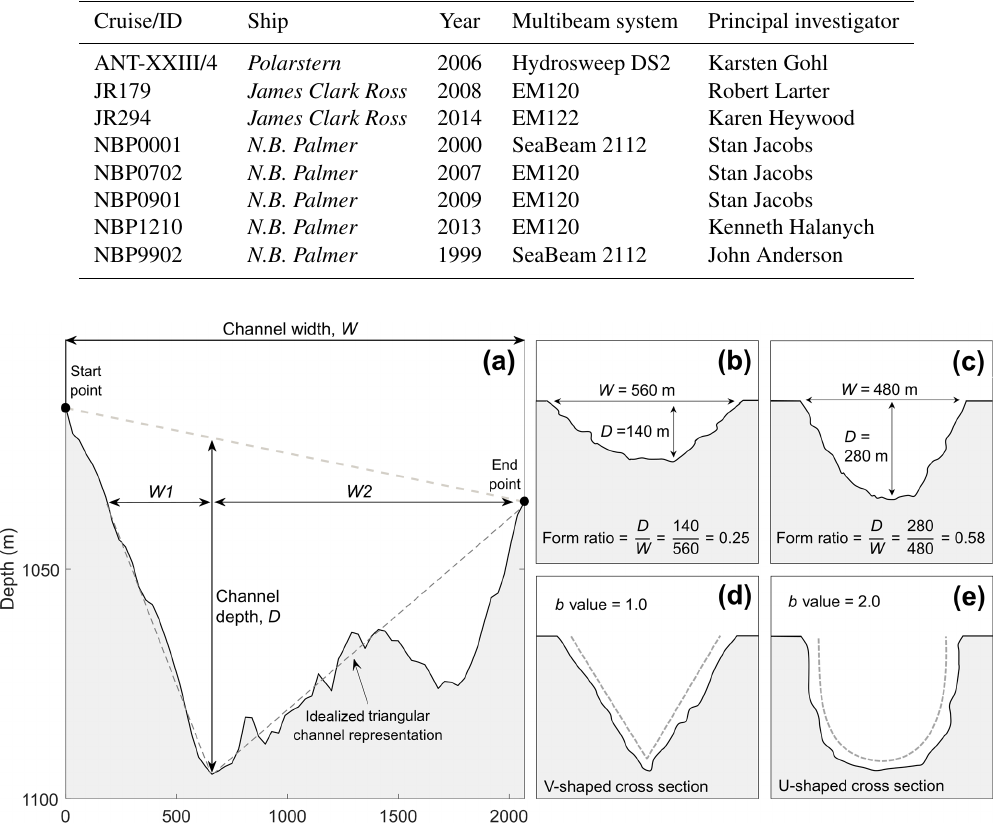
Table 1. Details of the geophysical cruise data used in this investigation.